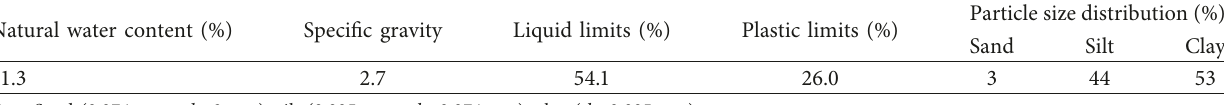
Table 1: Physical properties of soil for the experiment.